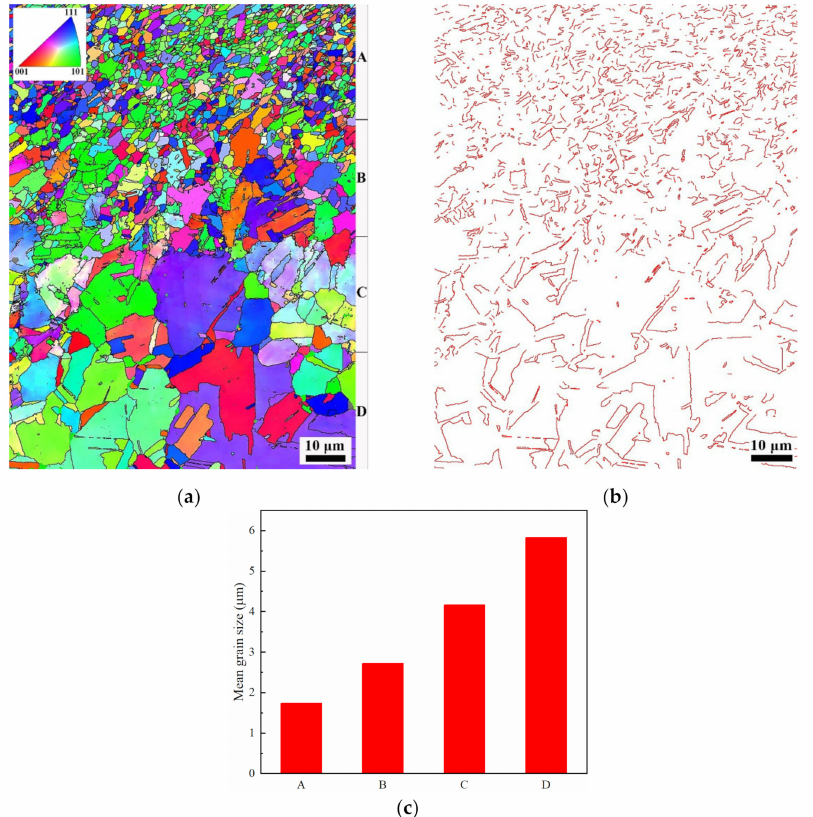
Figure 6. EBSD images of the specimen shot peened and subsequently annealed at 850 ◦ C: ( a ) inverse pole figure superimposed with grain boundaries, ( b ) map of ∑ 3 twin boundaries, and ( c ) mean grain size of the different layers indicated in ( a